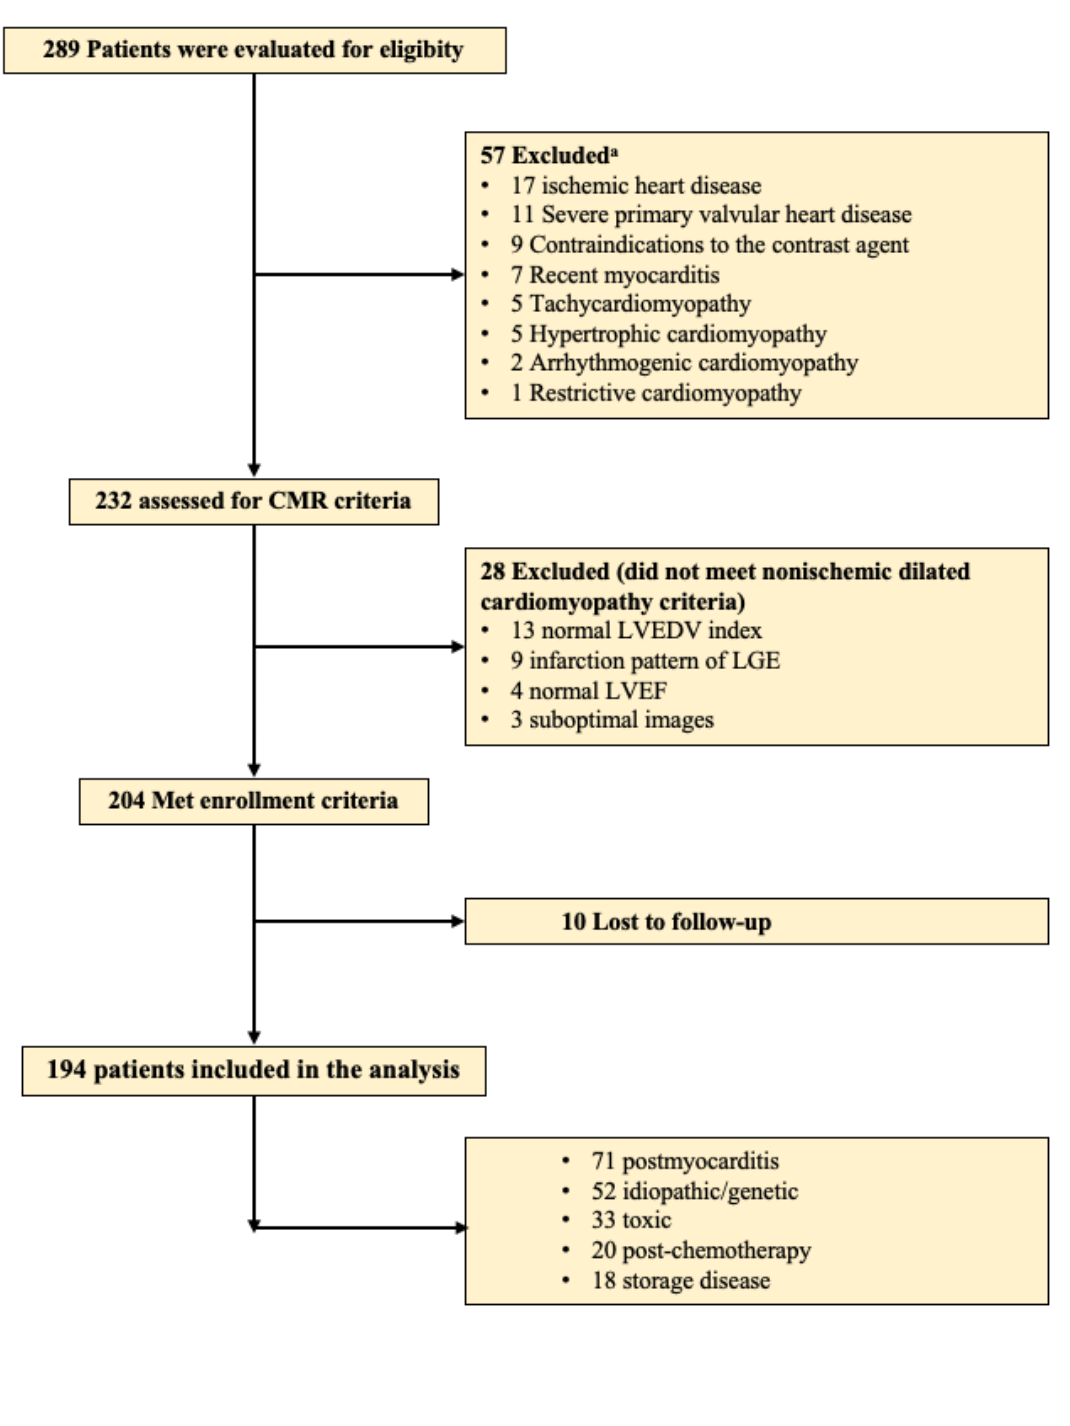
Figure 1. Flowchart of the study.